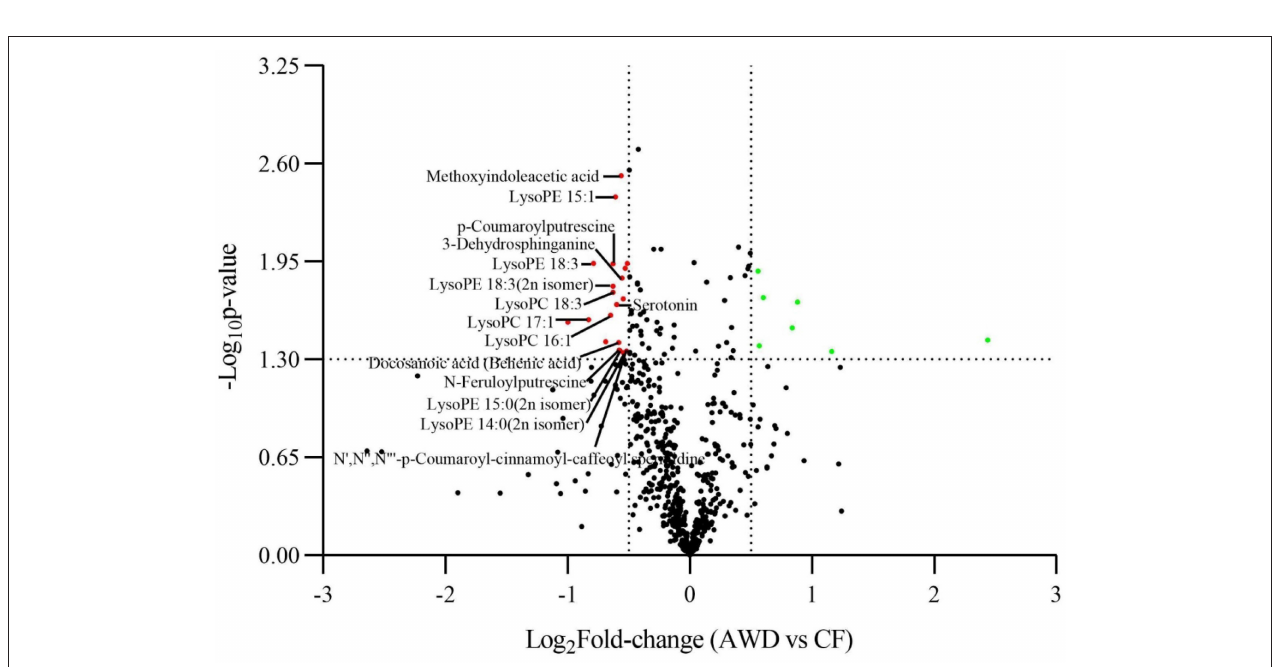
FIGURE 5 | Volcano plot comparison of differentially accumulated metabolites in AWD vs. CF. A plot correlating log 10 P -value with log 2 FC (AWD vs. CF) displaying metabolites up-/down-regulated in the metabolome assay. vs. log 2 FC (in AWD vs. CF), revealed that metabolites belonging to alkaloid and lipids metabolites were significantly down-regulated to a higher extent ( Figure 5 ). Among the highly down-regulated metabolites included LysoPC 17:1 and LysoPE 18:3.